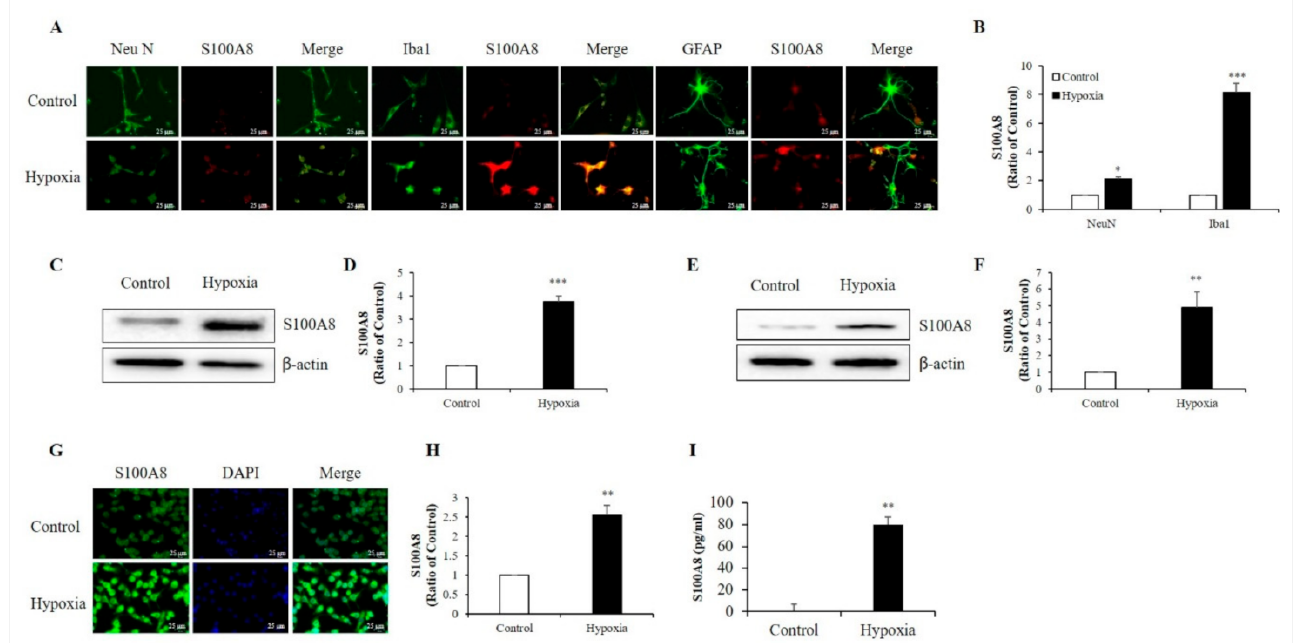
Figure 1. Hypoxia increased the production of S100 calcium-binding protein A8 (S100A8) in neuron and microglia and induced the release of S100A8 in SH-SY5Y cells. ( A , B ) S100A8 expression (red) were detected by immunocytochemical analysis in primary cultured neurons (NeuN, neuron marker) and cultured mixed glia (Iba1, microglial marker and GFAP, astrocyte marker) exposed to hypoxic conditions for 48 h. Scheme 25 µ m. S100A8 expression was detected by western blot analysis in ( C , D ) SH-SY5Y cells and ( E , F ) BV-2 cells exposed to hypoxic conditions for 48 h. ( G , H ) S100A8 protein expression in BV-2 cells were confirmed by immunocytochemistry and ( I ) S100A8 release in SH-SY5Y was measured by enzyme-linked immunosorbent assay (ELISA) at 48 h after hypoxia. Values of * p < 0.05, ** p < 0.01, *** p < 0.001 versus control were considered as statistically